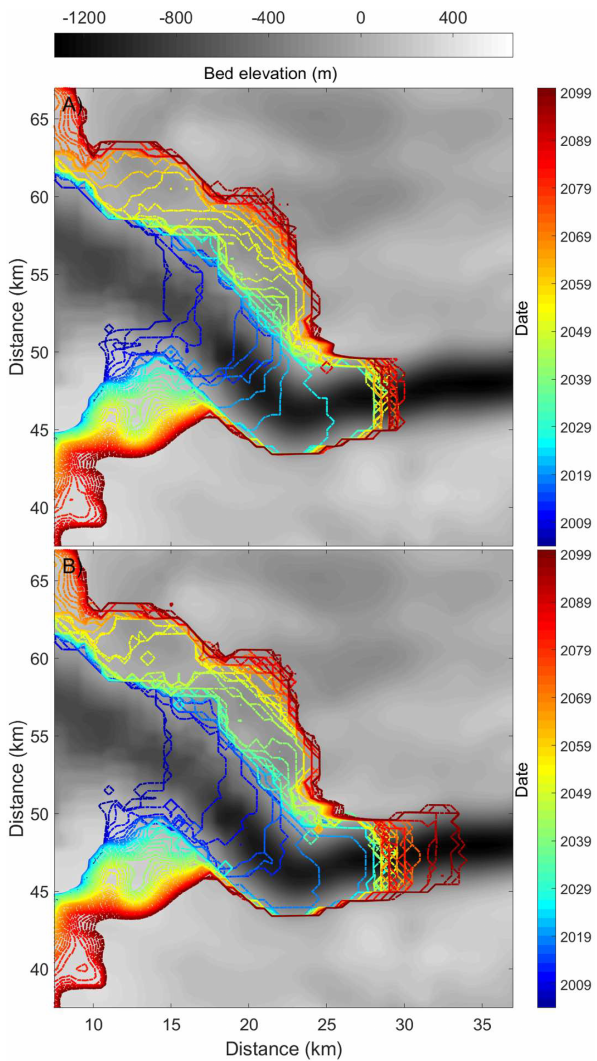
Figure 8. Upper and lower estimates of July front positions within this century with colors indicating the date (color bar) for (a) lower bound with scalings of (1,0.8) and the HadGEM-ES forcing (b) up- per bound of mass loss projection with ( α , γ ) parameter scalings of (1.2,1) and the seven-model-ensemble climate